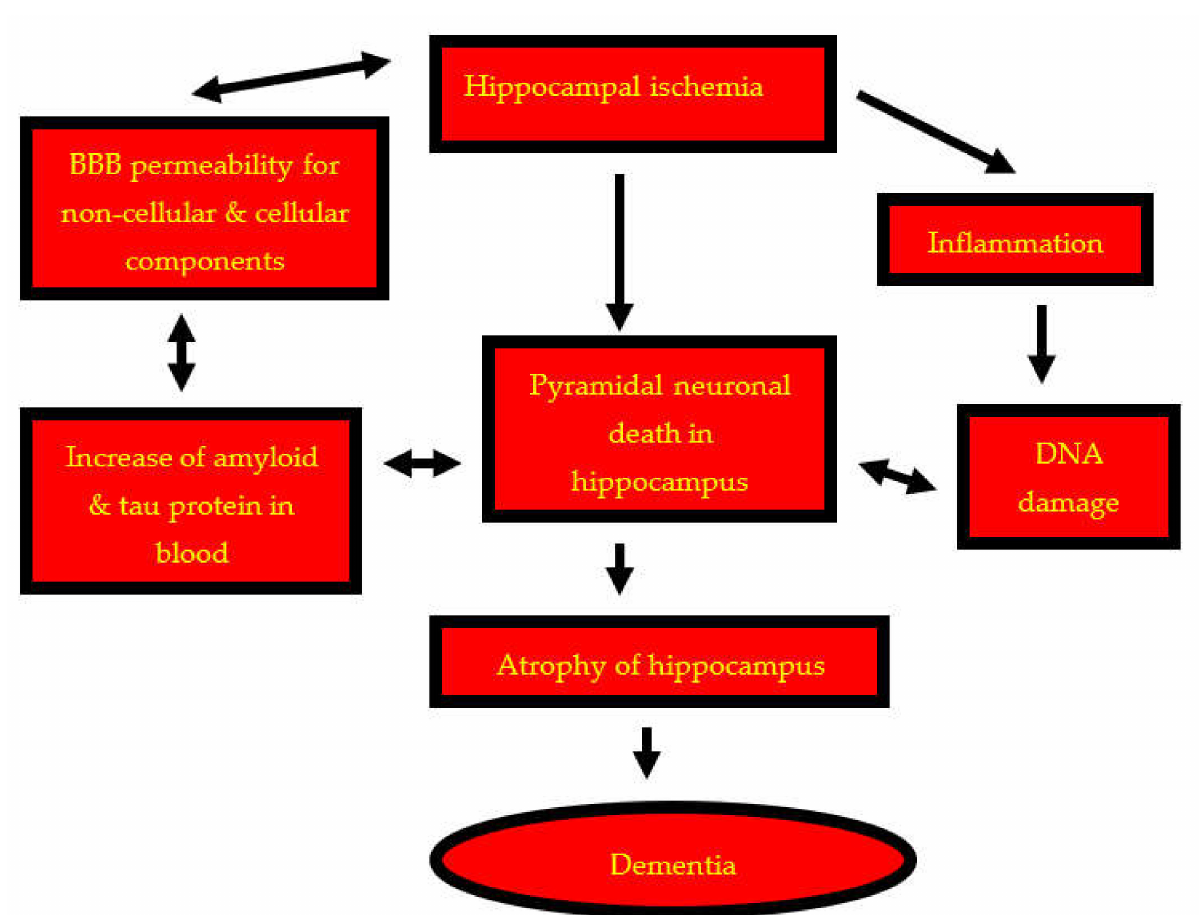
Figure 1. Development of pyramidal neuron death, atrophy of hippocampus and finally dementia. BBB—blood–brain